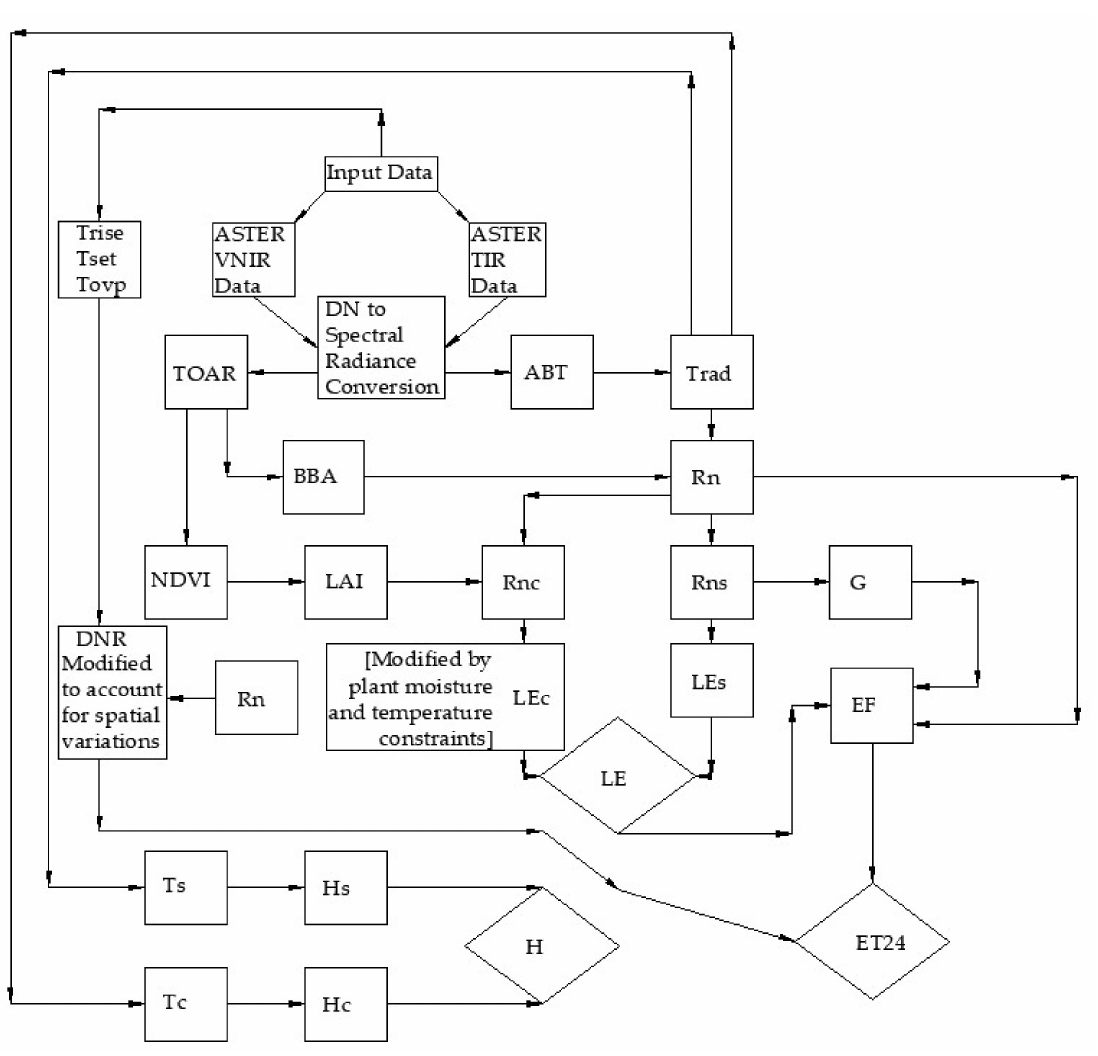
Figure 3. Flow chart of the novel Two-Source Energy Balance (TSEB) approach to estimation of daily evapotranspiration from Advanced Spaceborne Thermal Emission and Reflection Radiometer (ASTER) L1 T satellite